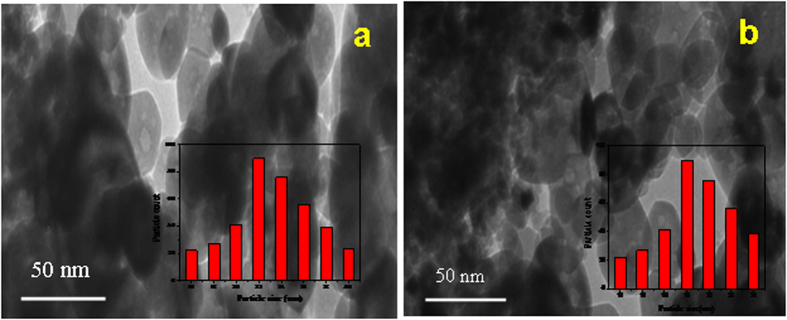
HR-TEM images of (a) CeO2 NPs prepared by the MCM and (b) CeO2 NPs prepare by the CRSGM.